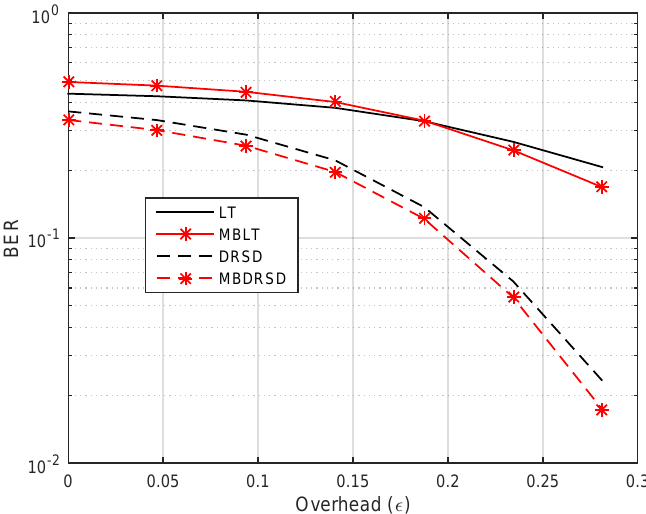
Figure 12. BER versus the overhead ( (cid:101) ) for different coding schemes at k = 256 and erasure probabilities of ε 1 = 0.01, ε 2 = 0.01, and ε 3 = 0.01.